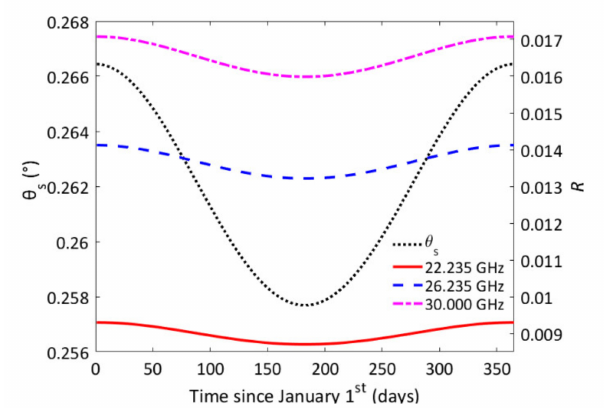
Figure 10. The ratio, R , varies with the angular radius of the sun throughout the year. θ s is the angular radius of the sun (left axis) and the ratio, R , is the ratio of the solar solid angle to the antenna solid angle (right